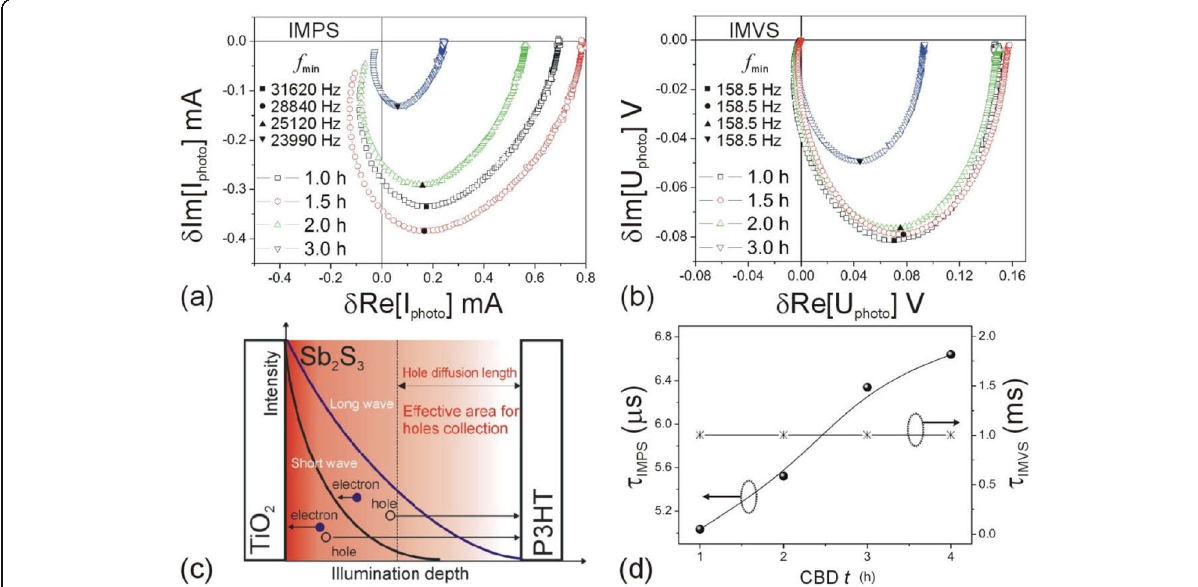
Fig. 10 a IMPS and b IMVS characterizations of solar cells with different CBD t for Sb 2 S 3 film. c Illustration of electron and hole diffusion area for short and long wavelength illumination. d Dependence of τ IMPS and τ IMVS on CBD